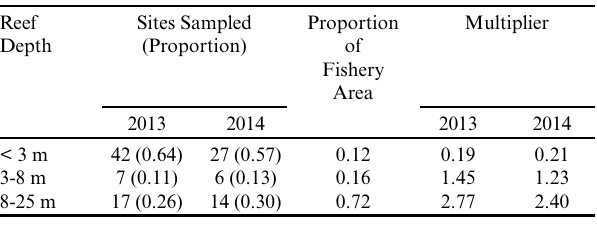
Table 1 . Fish community sampling was not proportional to the area of each depth category, and thus numbers at length were corrected to derive a whole-fishery estimate of population